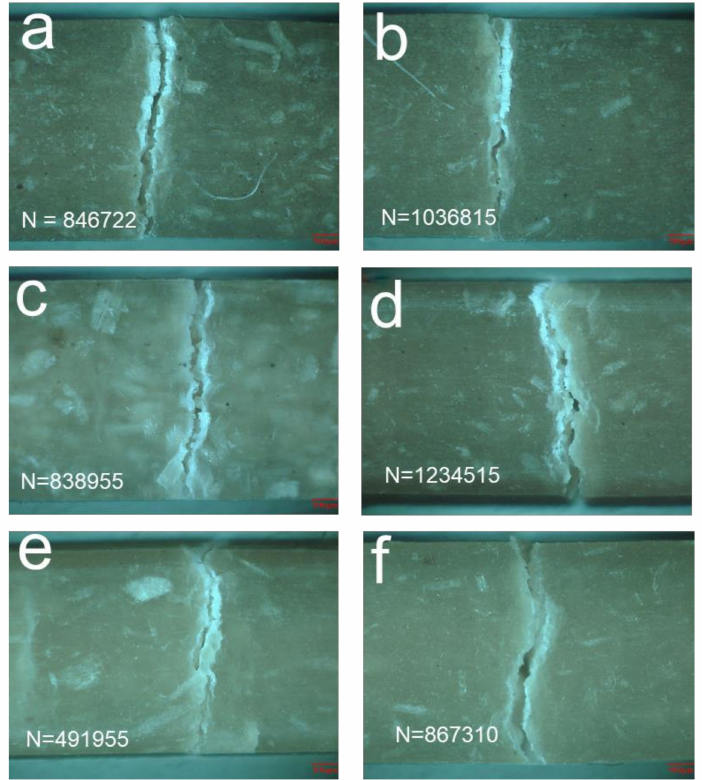
Figure 9. Optical microscopic images of fatigue fractured composites ( a ) CWF S 00, ( b ) CWF S 200w, ( c ) CWF L 00, ( d ) CWF L 200w, ( e ) PWF00, and ( f ) PWF200w. (N indicates number of cycles to fracture, and cyclic load was applied laterally on the